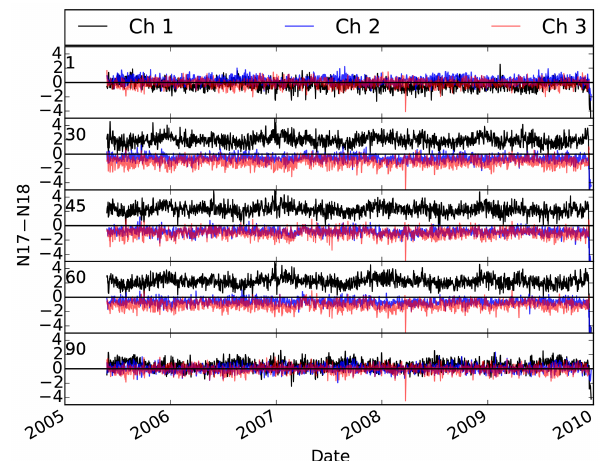
Figure 4. Effect of polarization on the difference between NOAA- 17 AMSU-B and NOAA-18 MHS observations for different FOVs over tropical ocean. FOV numbers are printed on the left side of each subplot. Channels 4 and 5 are not included because they were very similar to Channel 3.